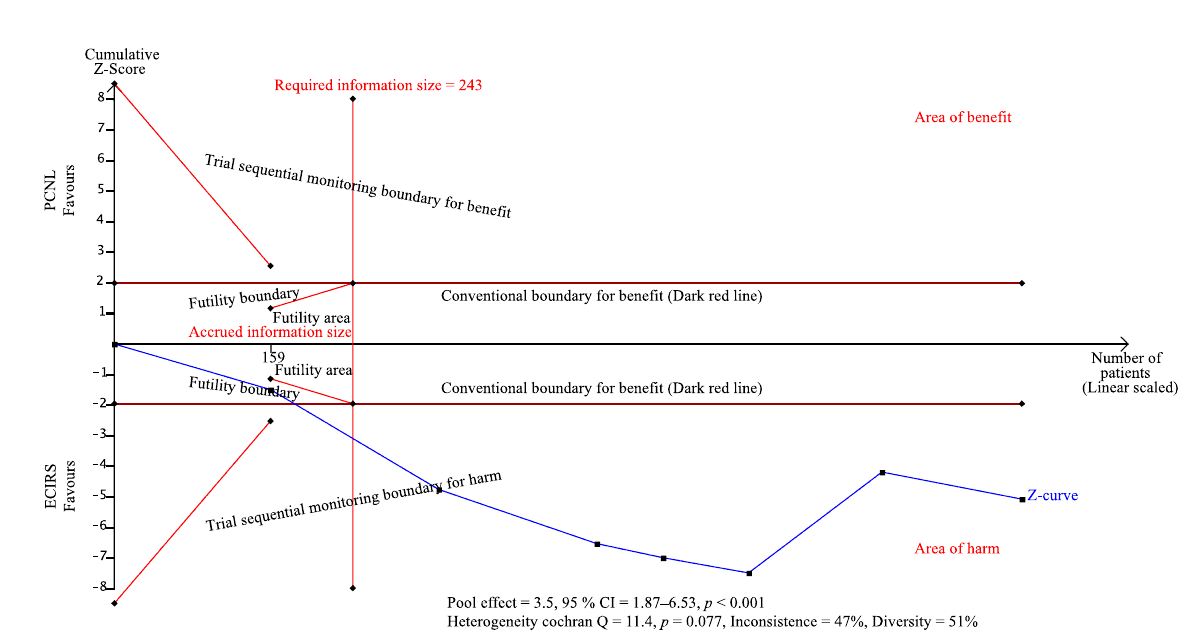
Figure A46. Trial sequential analysis of outcome regarding initial stone free rate.